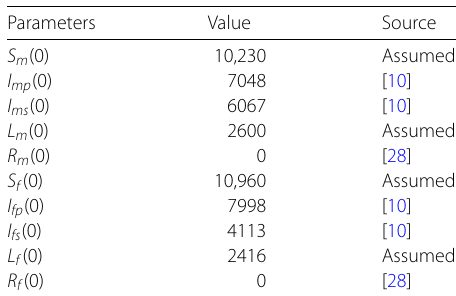
Table 4 Initial values for the